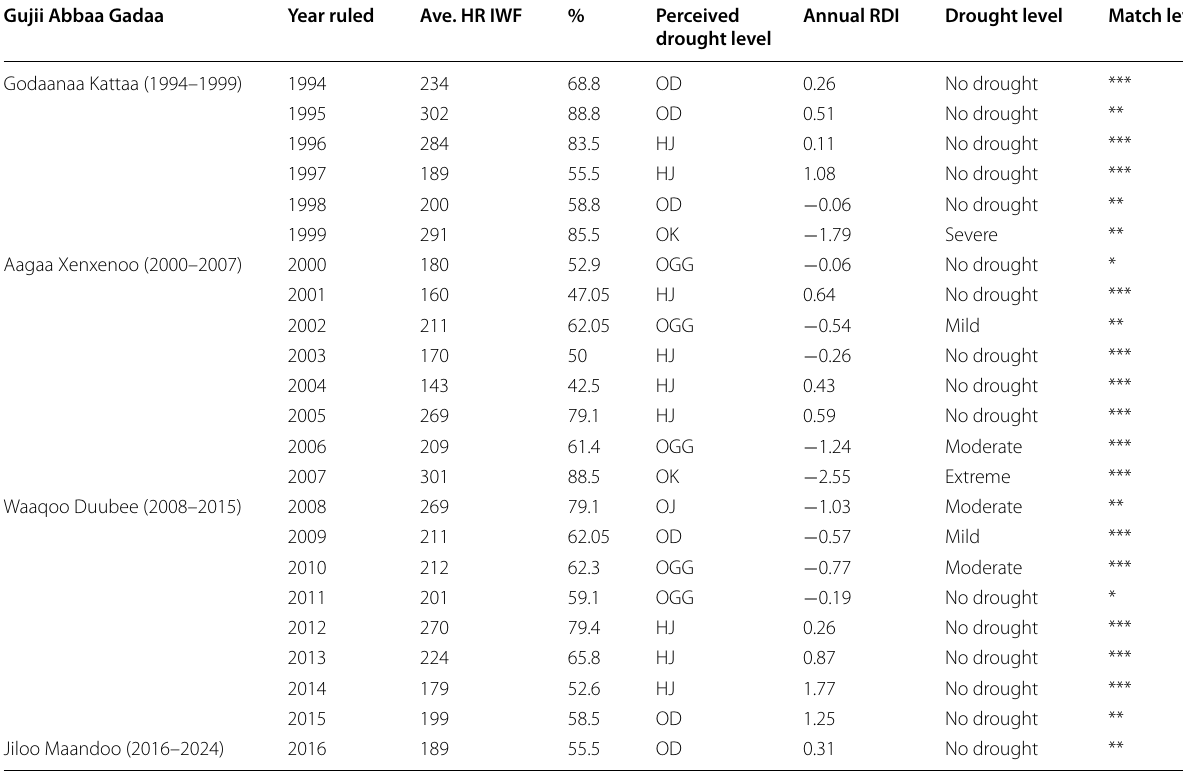
Table 4 Comparison of drought events using IK and meteorological data Gujii Abbaa